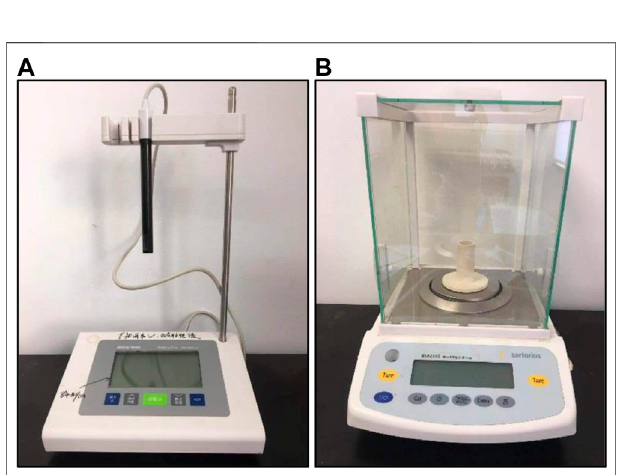
FIGURE 2 | The experimental device (A) conductivity meter and (B) experimental balance.